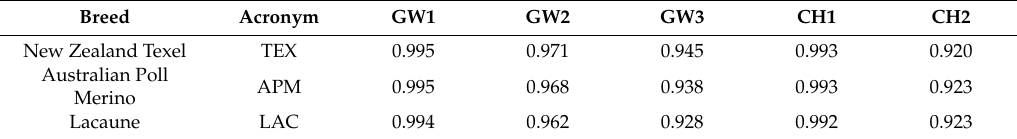
Table 3. Coe ffi cient of determination values calculated between the ancestry percentages obtained using the full SNP set and the AIMs in three commercial sheep